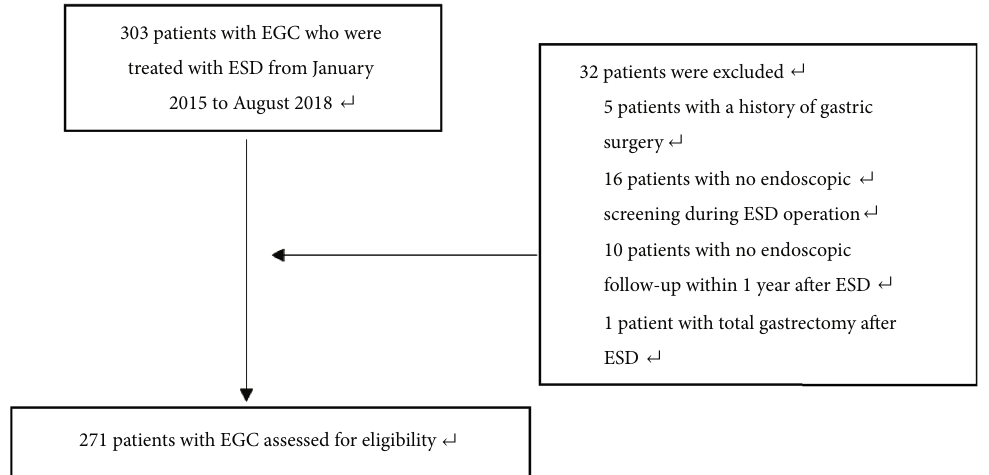
Figure 1: Patients